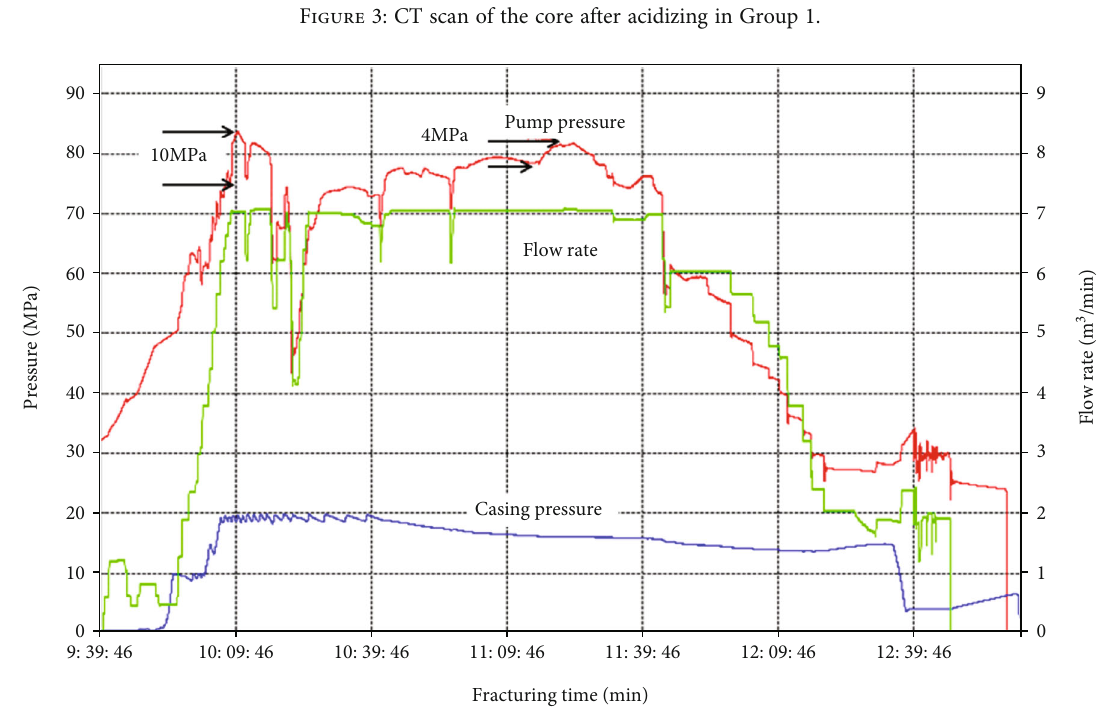
Figure 4: Acid fracturing curve of Well M.